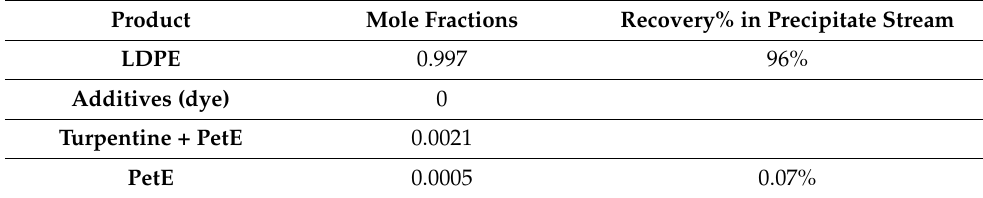
Table 8. Precipitated product stream composition and recovery.